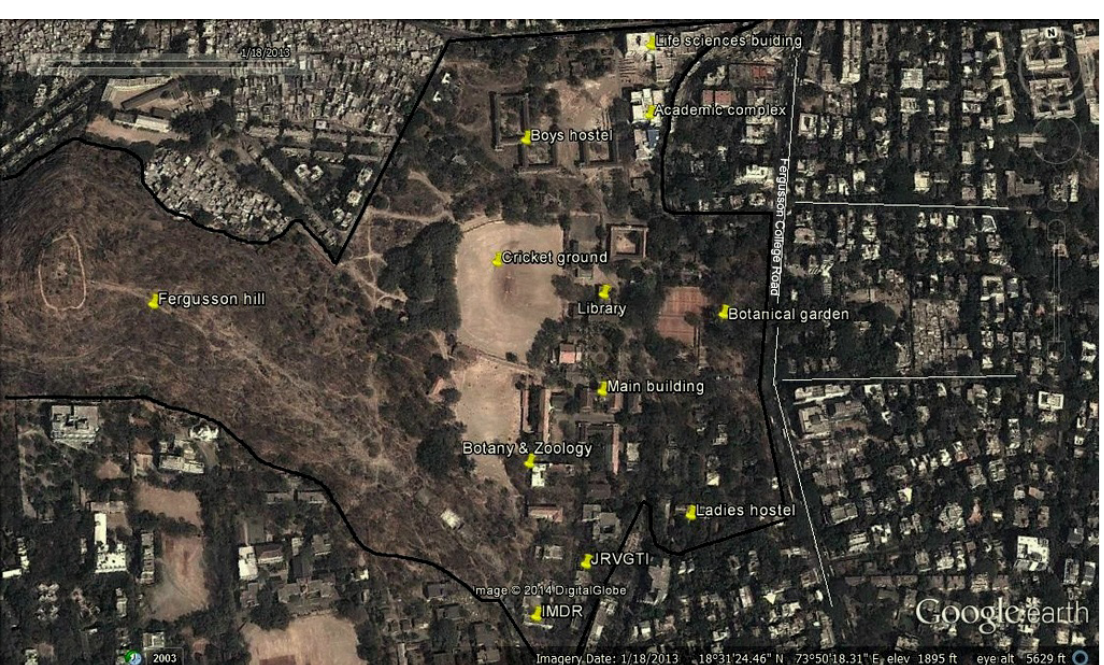
Figure 1. Study area with prominent landmarks (2014). College campus outlined in black and adjoining roads in white.